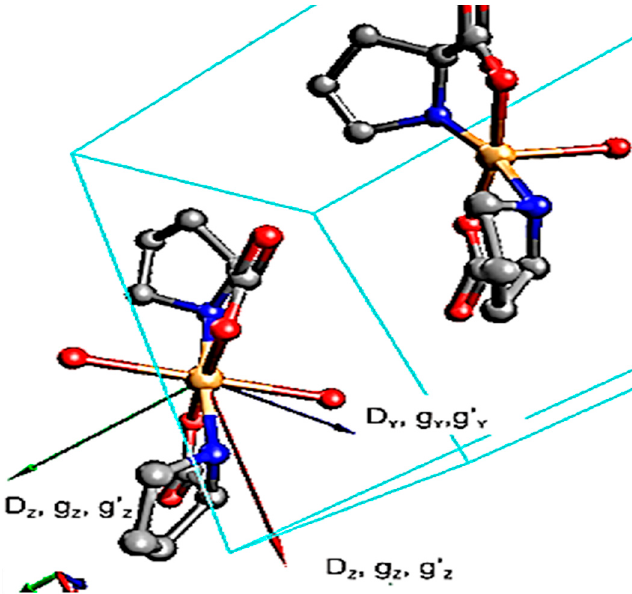
Figure 12. Orientated tensors D, g, g ′ obtained with CASSCF calculations for PCC. ZFS term causes splitting quartet ground state into two Kramers doublets with en- ergy gap, ∆